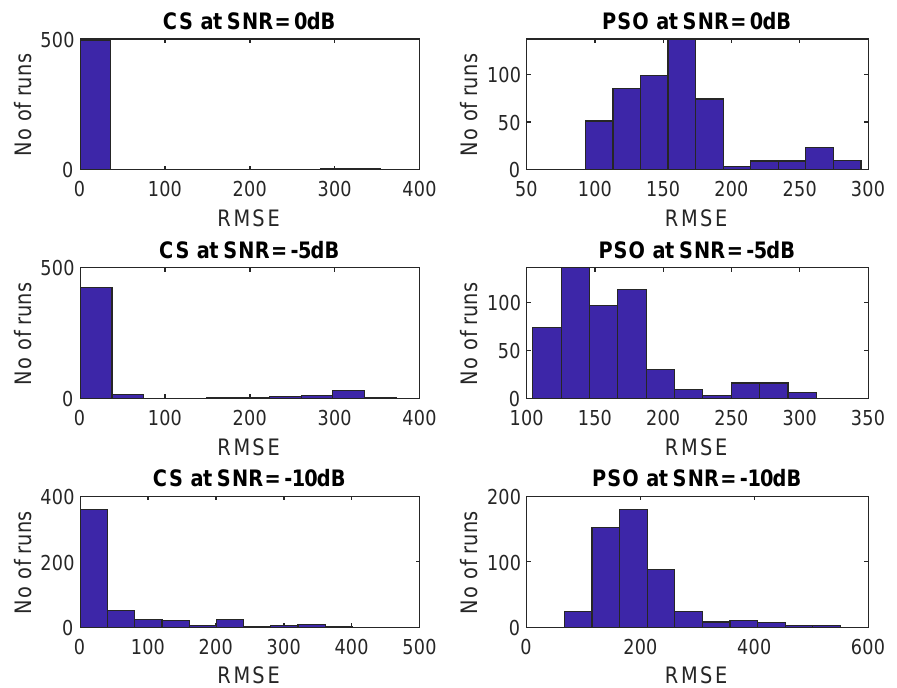
Figure 17. Correlation of proposed CS and PSO models based on RMSE using nine targets.